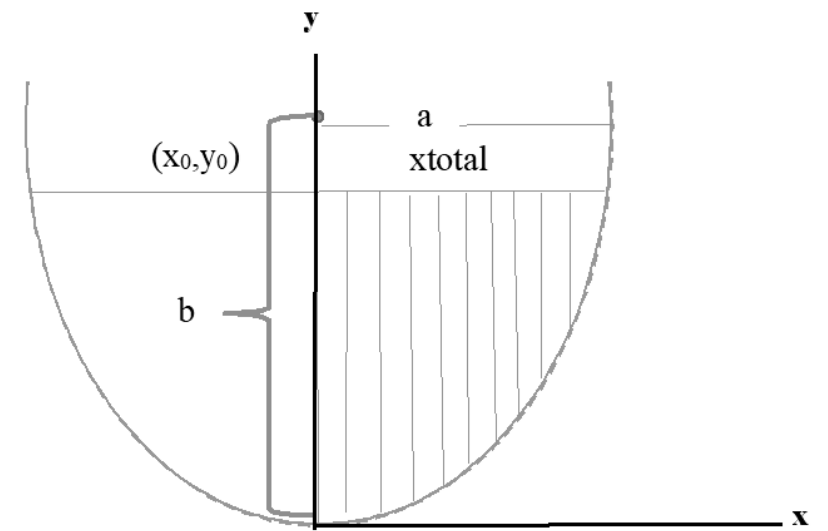
Figure 1. Flow Cross Sectional Area in the Semi-elliptical